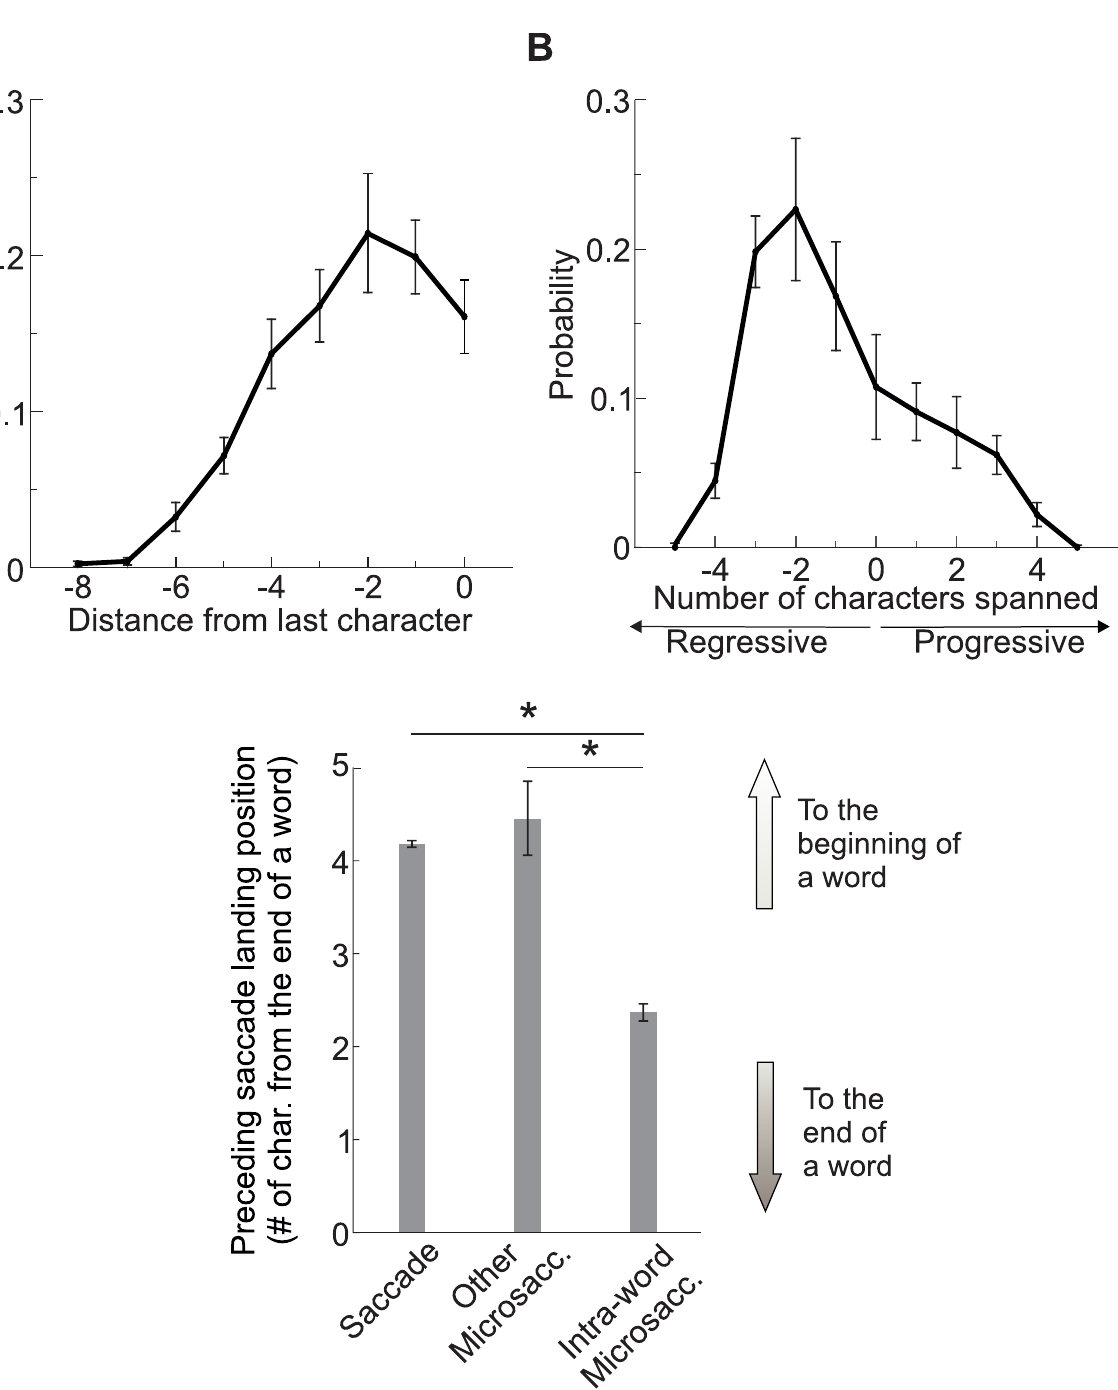
Fig 6. Intra-word microsaccadic gaze shifts. ( A ) Start positionof intra-wordmicrosaccades. The x-axis marks the number of characters from the last in a word. ( B ) Number of characters spannedby intra-word microsaccades. Positive and negative numbers indicate progressive and regressiveshifts, respectively.( C ) Landing positionsof saccades followedby different types of eye movements (saccades, intra-word microsaccade and other microsaccades). Data in C refer to saccadeslandingon words longerthan 7 characters. Error bars represent